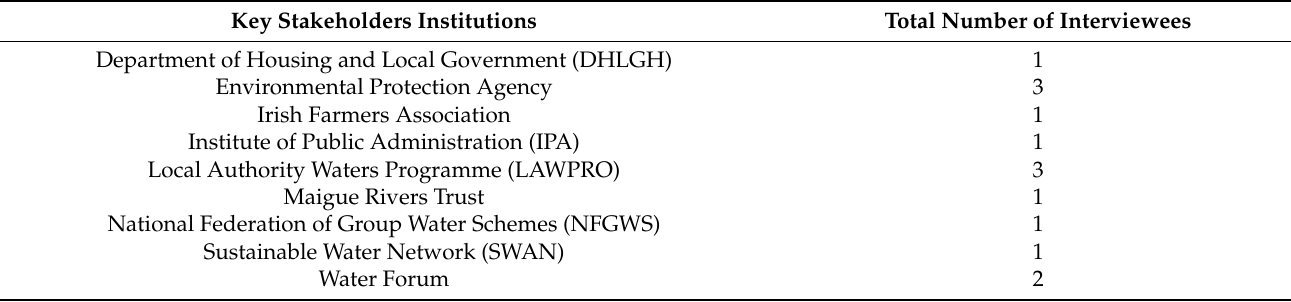
Table 1. Representative key stakeholders